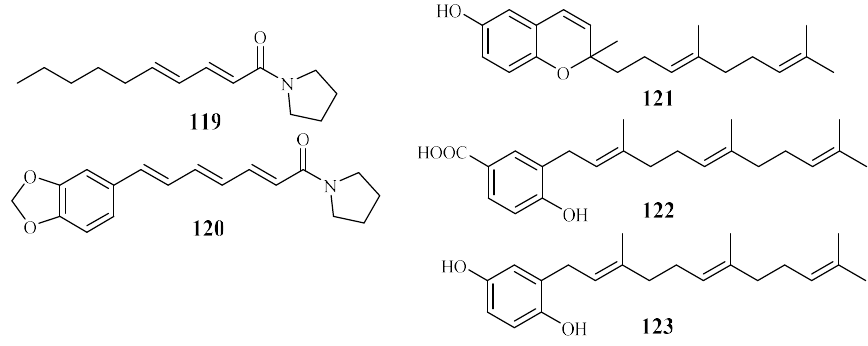
Figure 27. Compounds from Piperaceae plants.